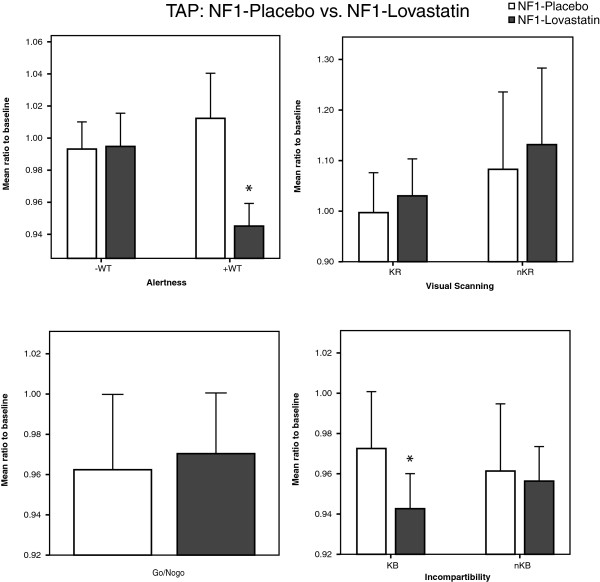
Reaction times of TAP in patients with NF1 with placebo or lovastatin medication. Data of 10 patients with NF1 are plotted for Alertness, Go/NoGo, Visual Scanning and Incompatibility. For phasic alertness and Incompatibility (KB) patients with NF1 (treated with lovastatin) scored in lower ranges than patients treated with placebo. The significance was set at a level of p < 0.05 and error bars represent ± standard error of the mean. Alertness: –WT (without warning tone), +WT (with warning tone); Visual Scanning: CS (critical stimulus), nCS (non critical stimulus); Incompartibility: CC (critical condition), nCC (non critical condition).